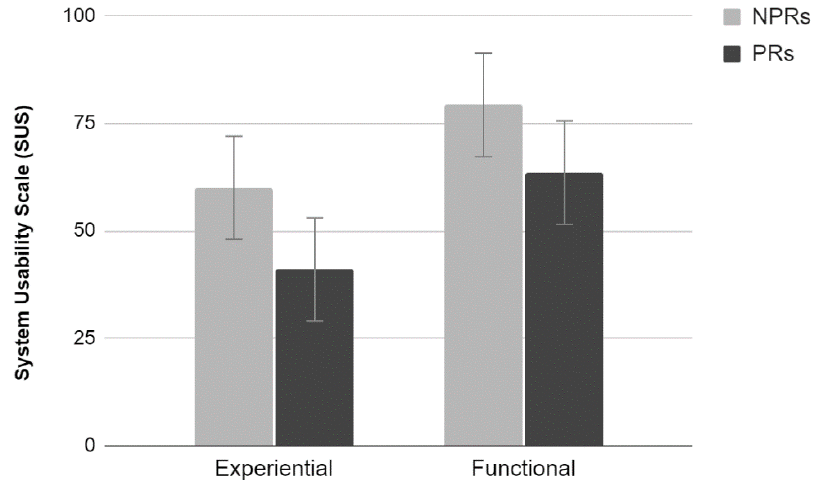
Figure 3. SUS scale score by Experience (NPRs vs. PRs) and Test (Experiential vs. Functional). Error bars denote 0.95 confidence intervals.